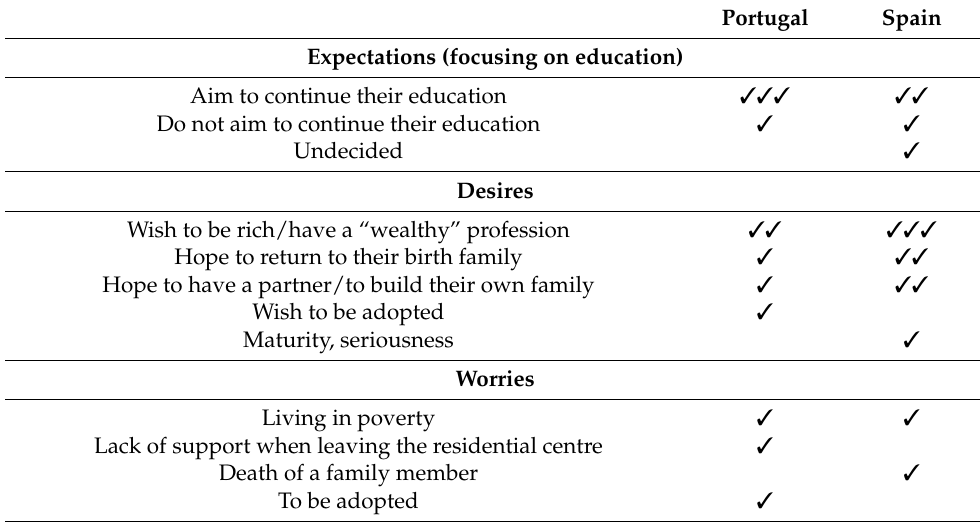
Table 6. Description of subcategories about future aspirations by countries.